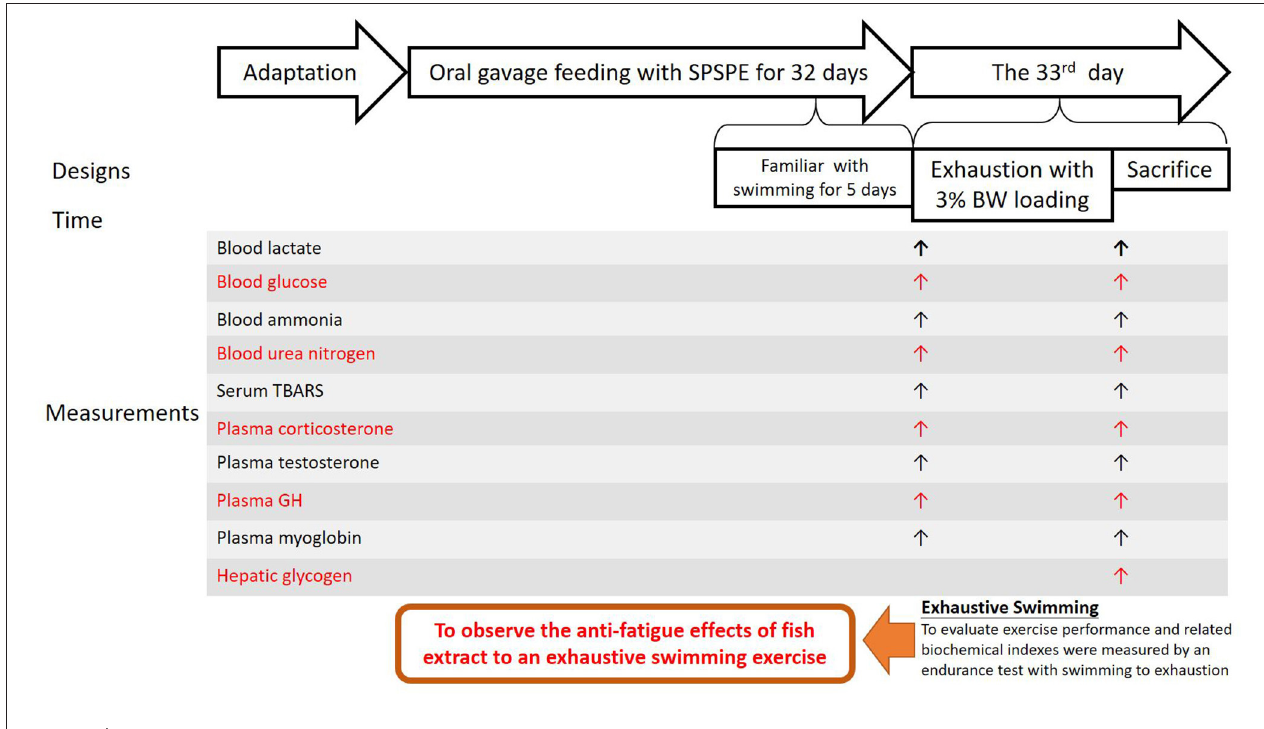
FIGURE 1 | Procedure and measurement of experimental